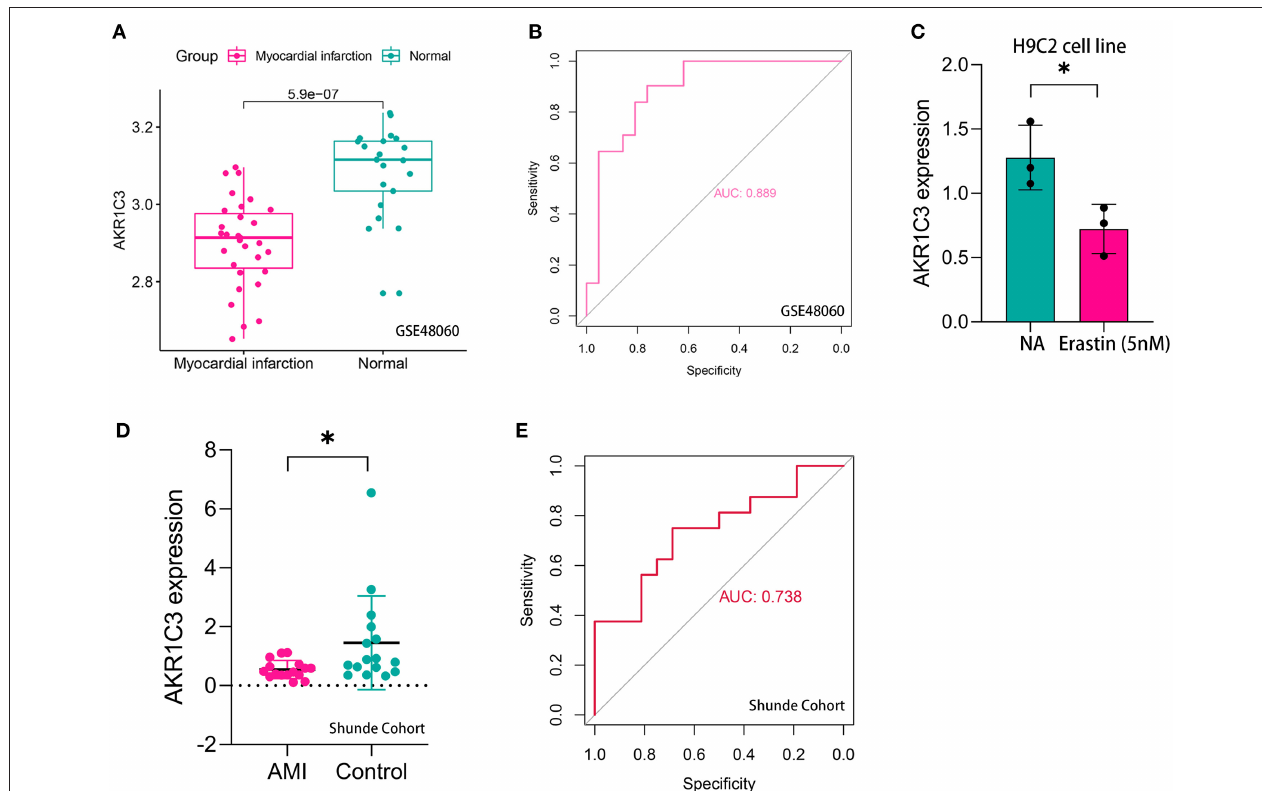
FIGURE 3 | AKR1C3 was a ferroptosis-related biomarker for acute myocardial infarction (AMI) diagnosis. (A) AKR1C3 was significantly downregulated in AMI samples of the GSE48060 cohort. (B) The receiver operating characteristic (ROC) curve for the diagnostic value of AKR1C3 in GSE48060. (C) AKR1C3 was downregulated in H9C2 cells treated with 5nM erastin. (D) AKR1C3 was significantly downregulated in AMI samples of the local cohort. (E) The ROC curve for the diagnostic value of AKR1C3 in the local cohort. * p <